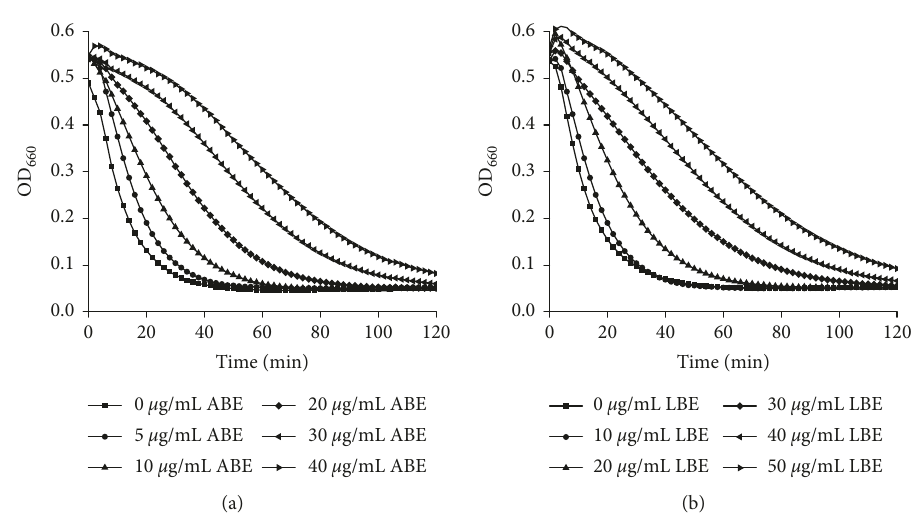
Figure 4: Kinetic curves of starch hydrolysis by α -amylase under different concentrations of the inhibitor.